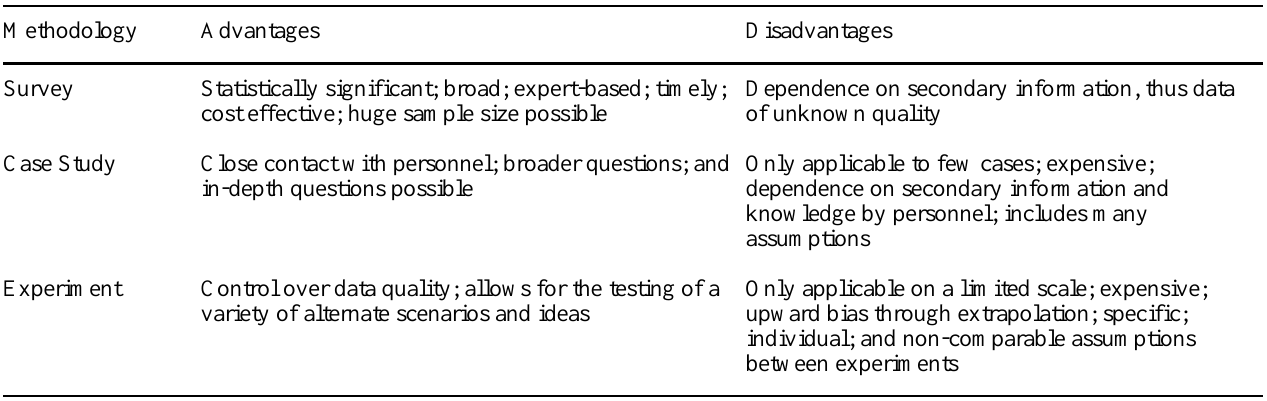
Table 3 . Advantages and disadvantages of previous research methodologies Methodology Advantages Disadvantages Survey Case Study